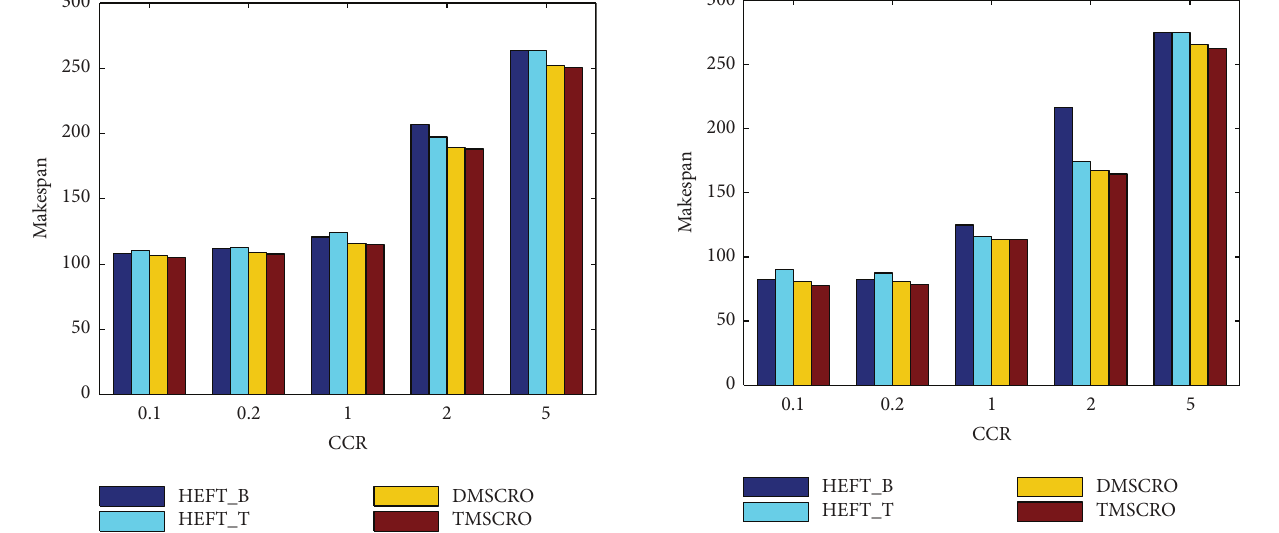
Figure 16: Average makespan for Gaussian elimination; the number of processors is 8.